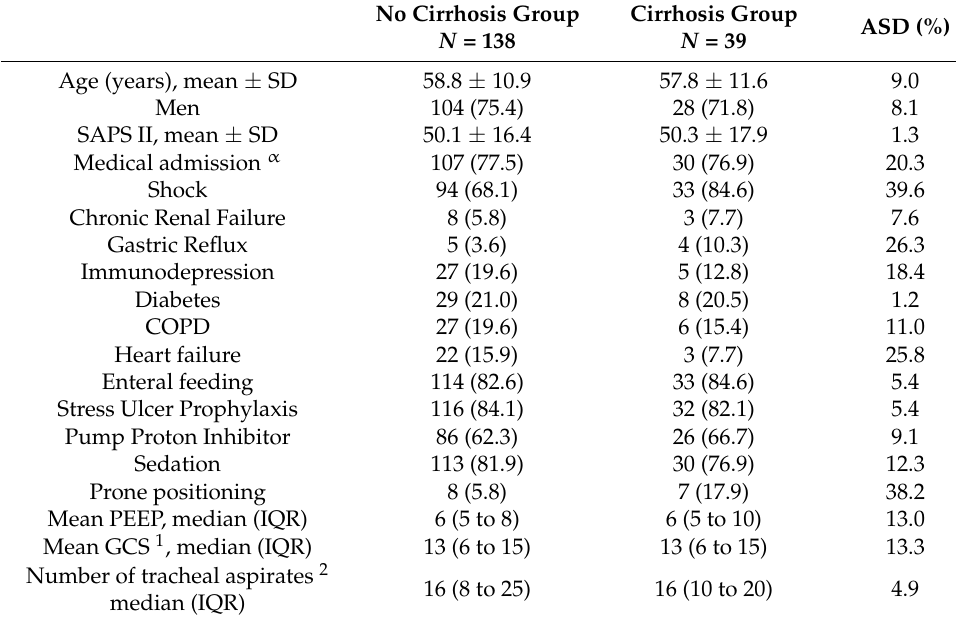
Table 2. Patient characteristics according to the group, after matching.